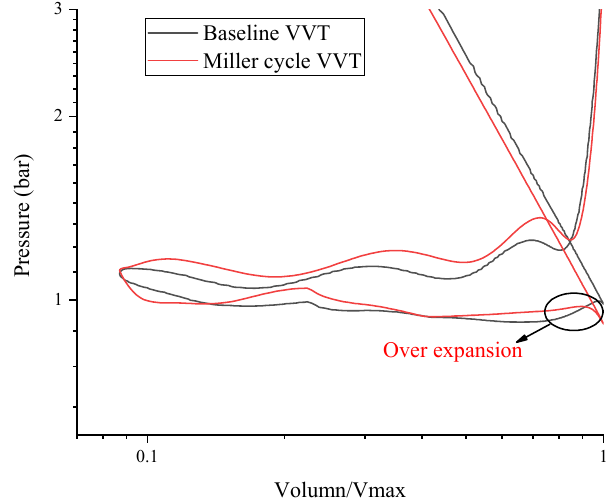
Figure 18. The logP versus logV diagram of the baseline VVT (Variable Valve Timing) and Miller cycle VVT (point of operation: n = 3000 rpm, BMEP = 10 bar, CA50 = 8 °CA).